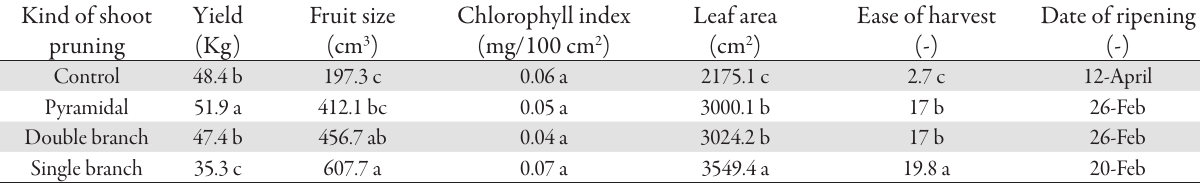
Tab. 1. Effect of shoot pruning on quantity of Semi-determinate tomato in greenhouse Kind of shoot